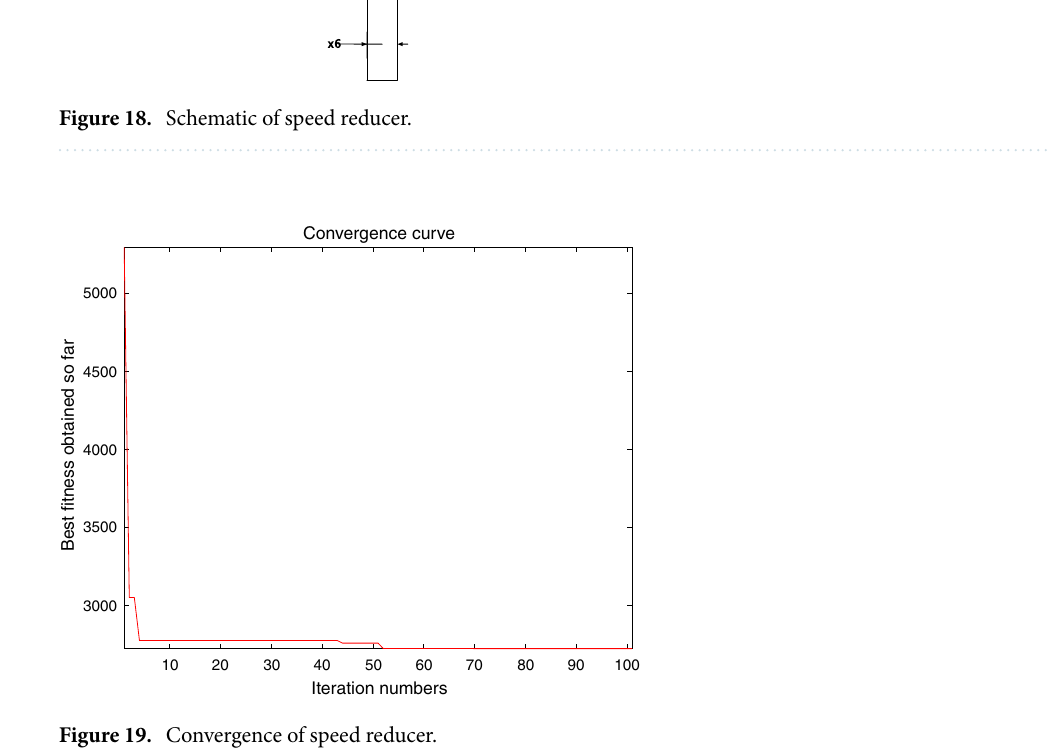
Figure 19. Convergence of speed